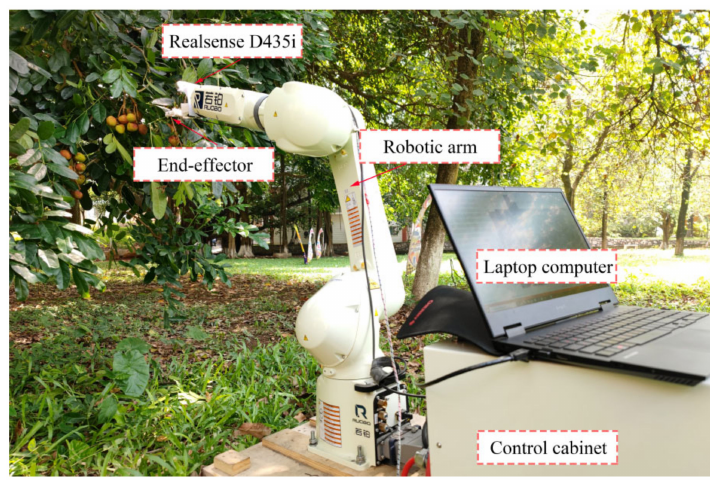
Figure 16. Photograph of the platform.